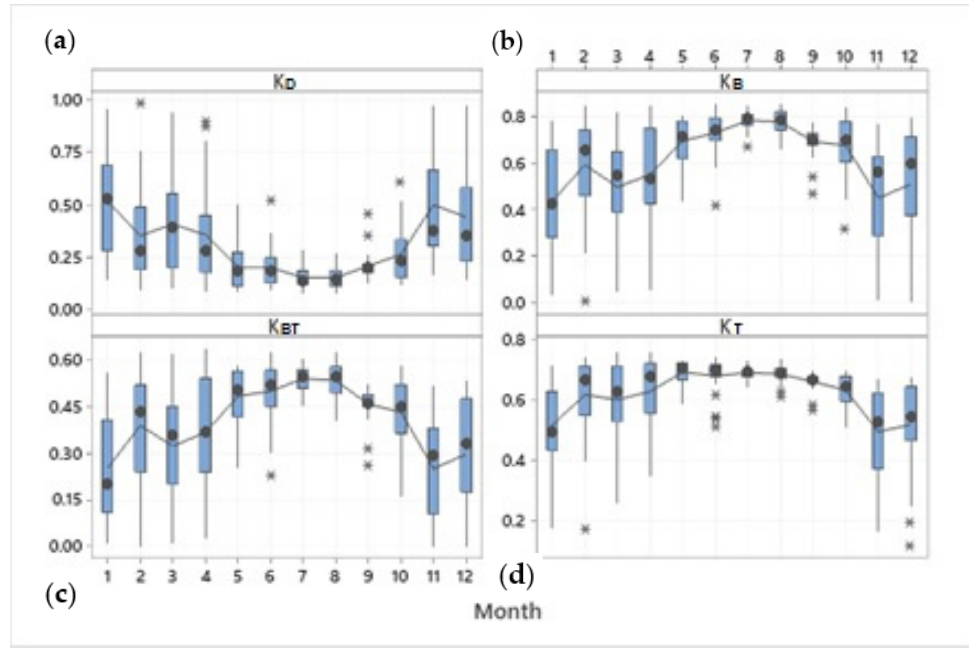
Figure 27. Monthly boxplots for each daily radiation index: ( a ) diffuse fraction ( K D ); ( b ) direct horizontal fraction ( K B ); ( c ) direct clearness index ( K BT ); and ( d ) clearness index ( K T ). Daily Clearness Index ( K T ) and Relative Sunshine Duration ( σ ) K T is an objective measure of the influence of cloud cover on solar radiation flux. As indicated earlier, the sky conditions could be classified in four intervals of clearness in- dex. The monthly statistics of K T are reported in Table 9. Also listed in the table is the number of days according to the above classification for each month of the year. The annual average of K T is 0.620 with a standard deviation of 0.121. The monthly average values of the daily clearness index range between 0.497 in November to 0.692 in July. The annual number of cloudy days is 17 (4.66%), the respective number of partially cloudy days is 137 (37.53%) and 211 days are classified as clear days representing the 57.81% of the annual number of days. As it can be seen the summer months are classified mainly as clear days. It has to be noted that the year of measurements is considered as a dry year. Table 9. Monthly statistics of K T and the number of days (N) and their percentage according to the classification of days with respect to K T for each month of the year.